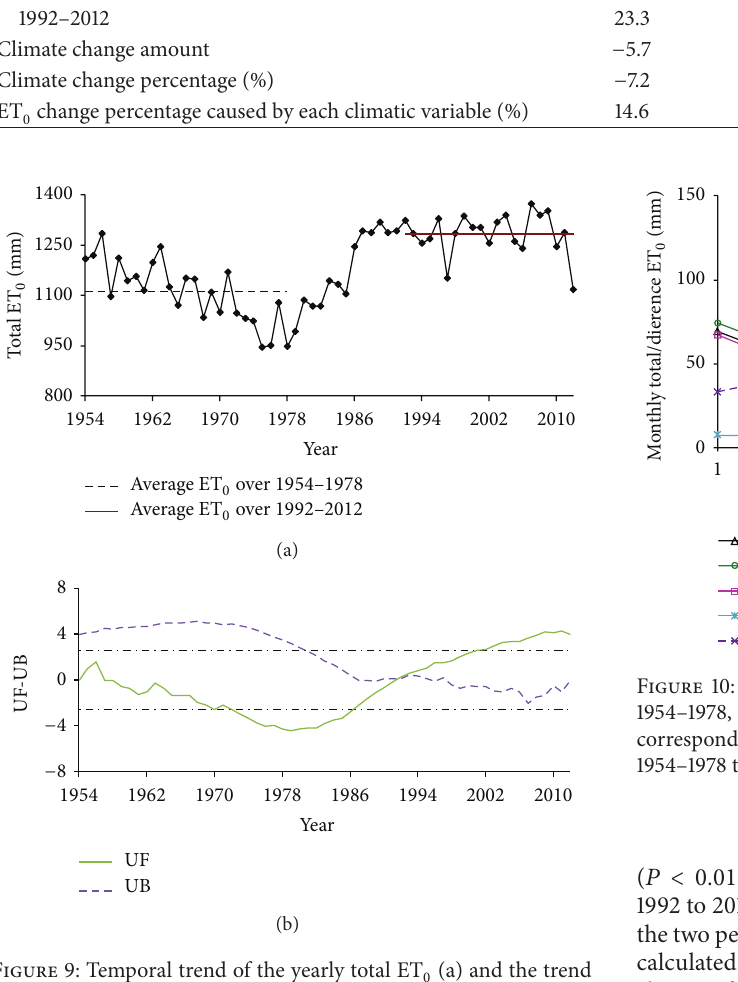
Figure 9: Temporal trend of the yearly total ET 0 (a) and the trend results from the Mann-Kendall method (b).